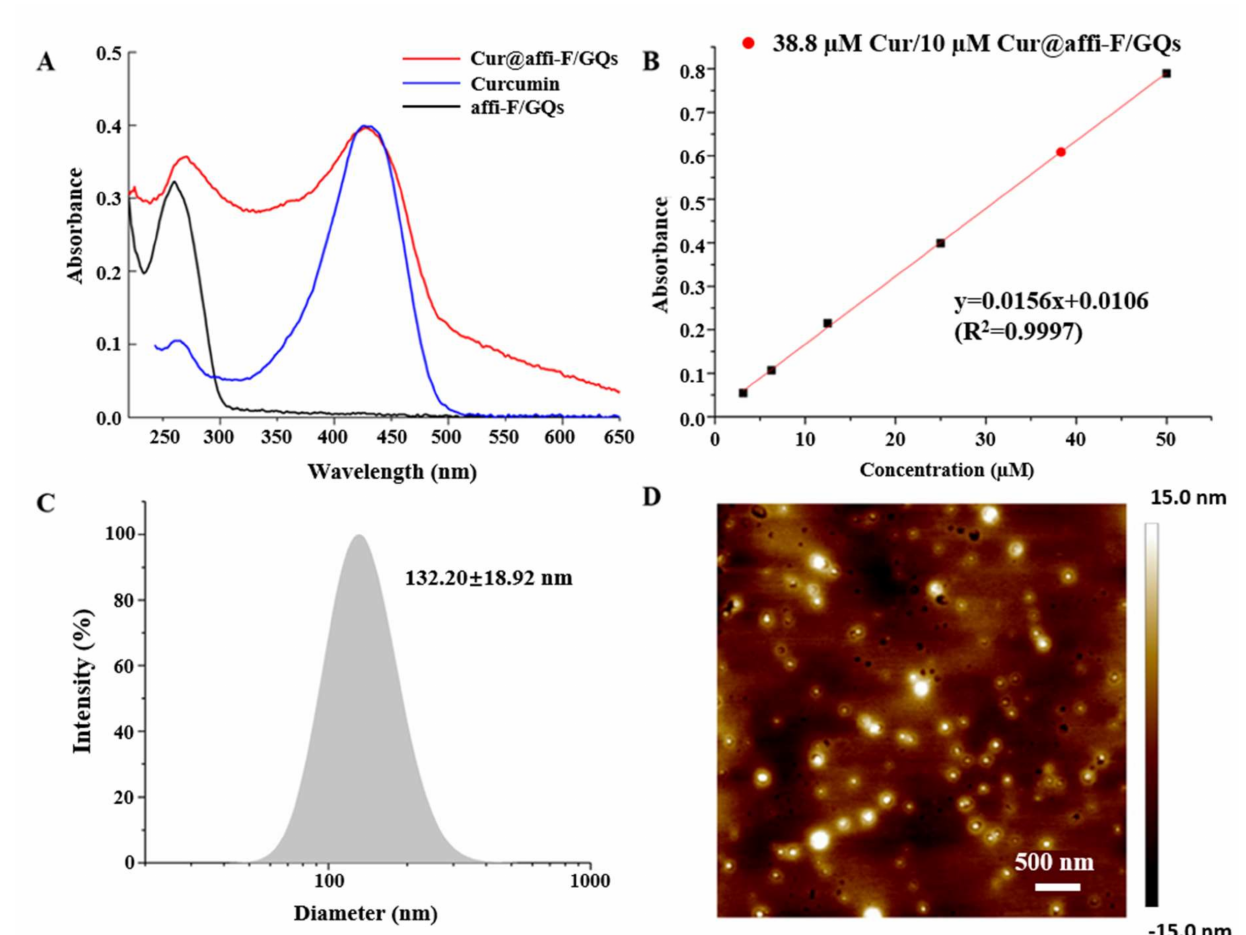
Figure 4. ( A ) UV-vis spectra of Cur@affi-F/GQs, Cur and affi-F/GQs. ( B ) Standard curve of Cur and determination of Cur content in Cur@affi-F/GQs. ( C ) Size distribution of Cur@affi-F/GQs. ( D ) AFM image of